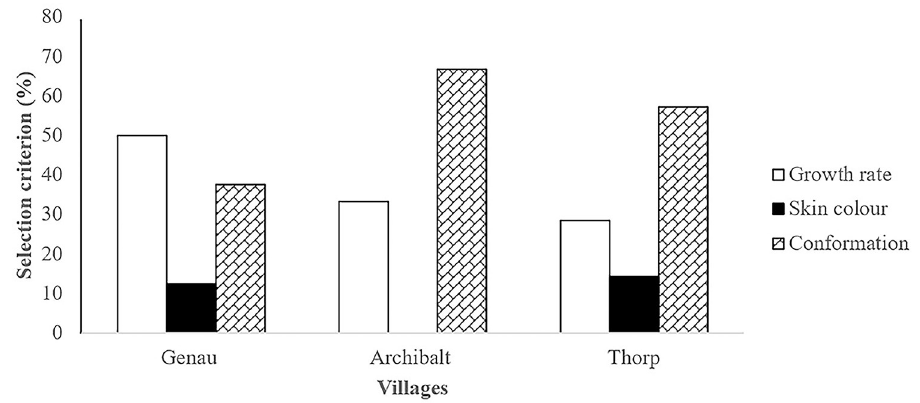
Fig 2. Selection criterion used by donkey farmers.